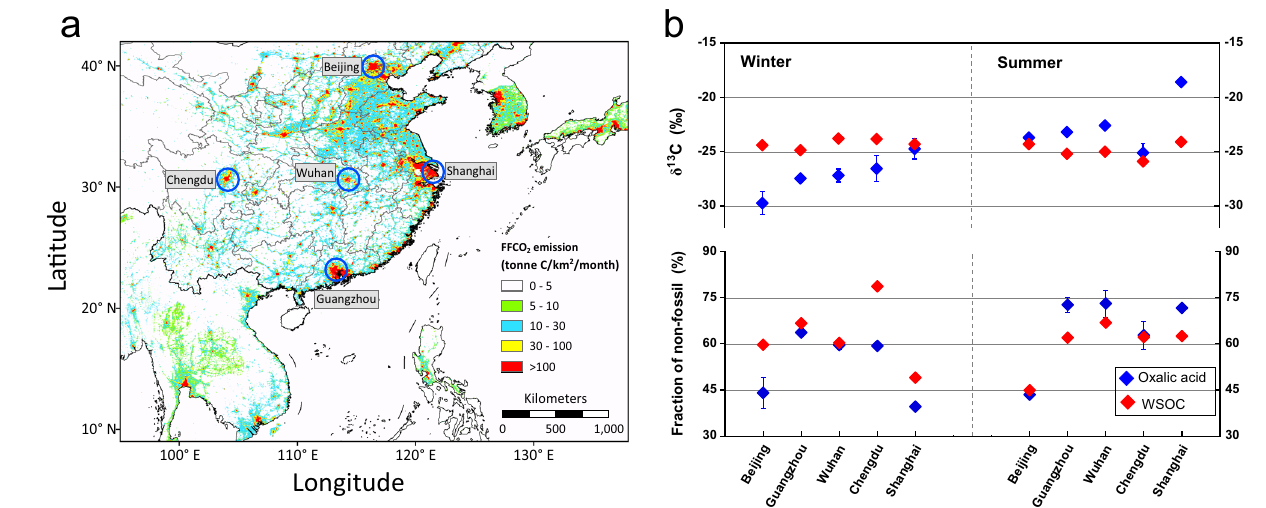
Fig. 6 | The δ 13 C composition and 14 C-based source apportionment of water- soluble organic carbon (WSOC) and oxalic acid in PM 2.5 collected from fi ve emissionhotspotmegacitiesofChina.a Locationsofthe fi vemegacities(Beijing, Guangzhou, Wuhan, Chengdu and Shanghai) and average fossil fuel CO 2 (FF CO 2 ) emissions during the year 2018. FF CO 2 emissions indicating high levels of anthropogenic activities over the fi ve megacities. The FF CO 2 emission data is obtained from Open-source Data Inventory for Anthropogenic CO 2 (https://db. cger.nies.go.jp/dataset/ODIAC/DL_odiac2020b.html). The coastline boundaries in the map are originated from Natural Earth free vector map data (https://www.